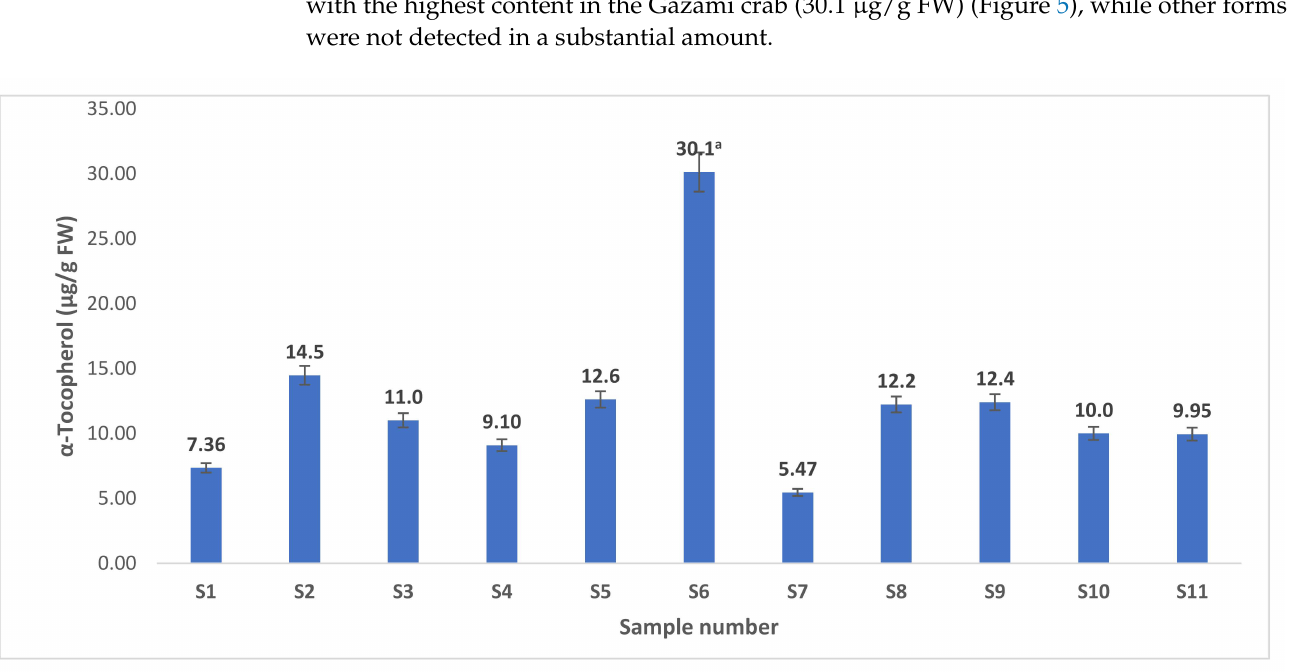
Figure 5. The contents of α -tocopherol ( µ g/g fresh weight) of the studied shellfish species. Values are mean ± standard deviation of three replicates. a The mean value is significantly ( p < 0. 05, Turkey HSD) highest among the studied species. The sample numbers (S1 to S11) correspond to Table